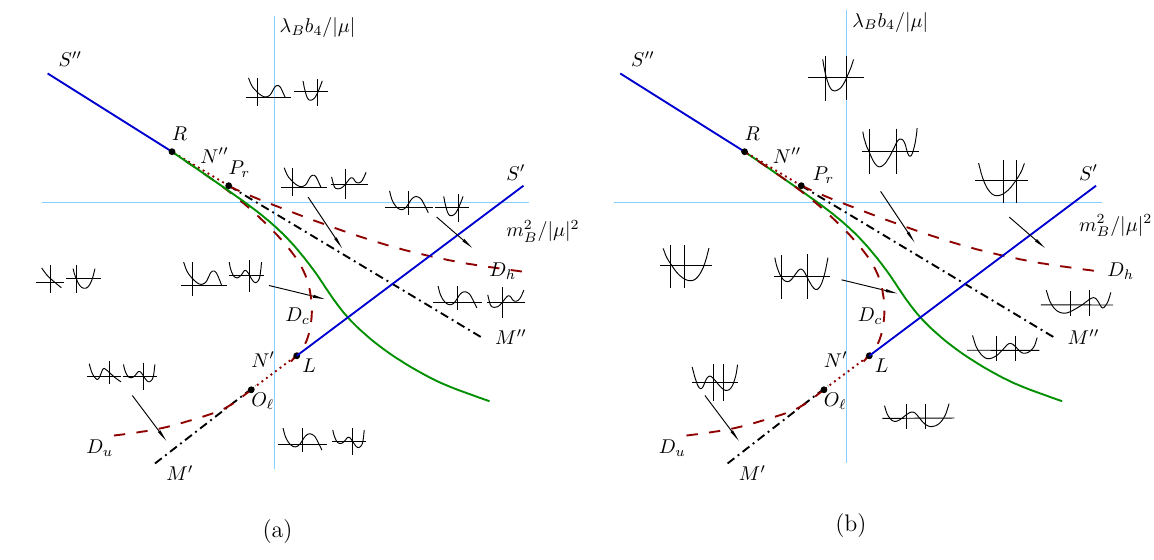
Figure 13 . Structure of the potential for φ h < x B < 0 . The green curve is a first order transition 6 while the blue curves are second order transitions. We have restored the | µ | dependence of the phase diagram by rescaling m 2 and λ B b 4 by appropriate powers of | µ | . B